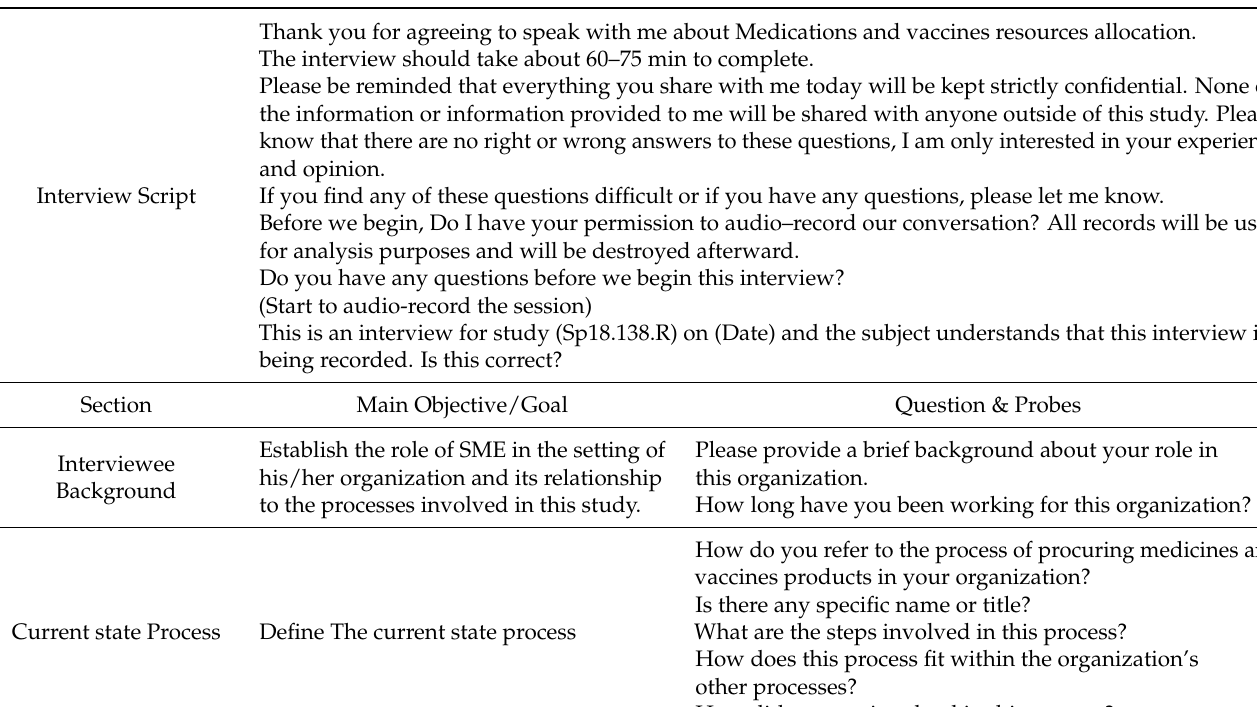
Table A1. Interview